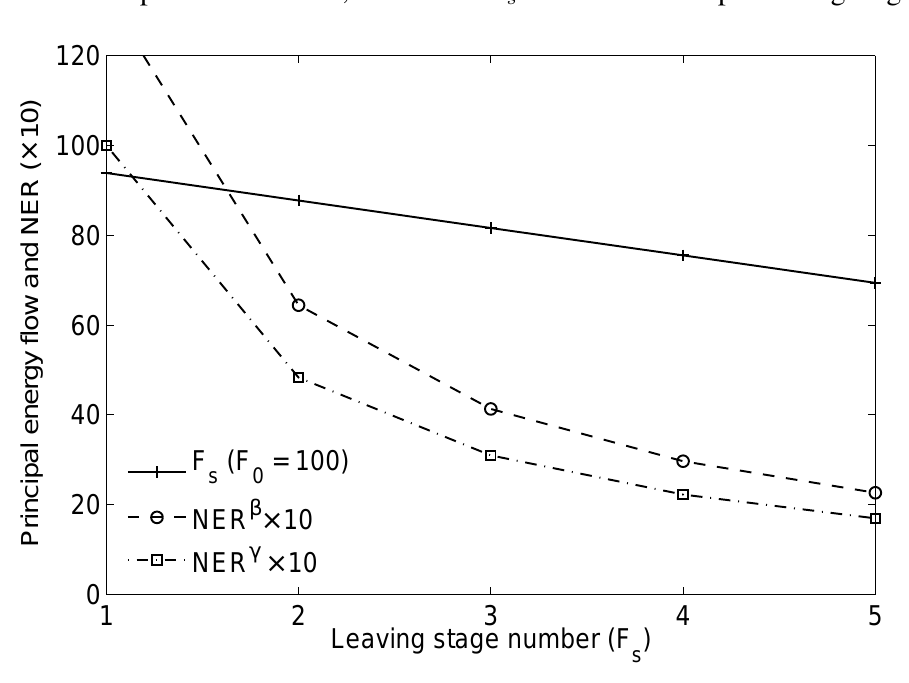
Figure 5. Comparison of NER β , NER γ and F